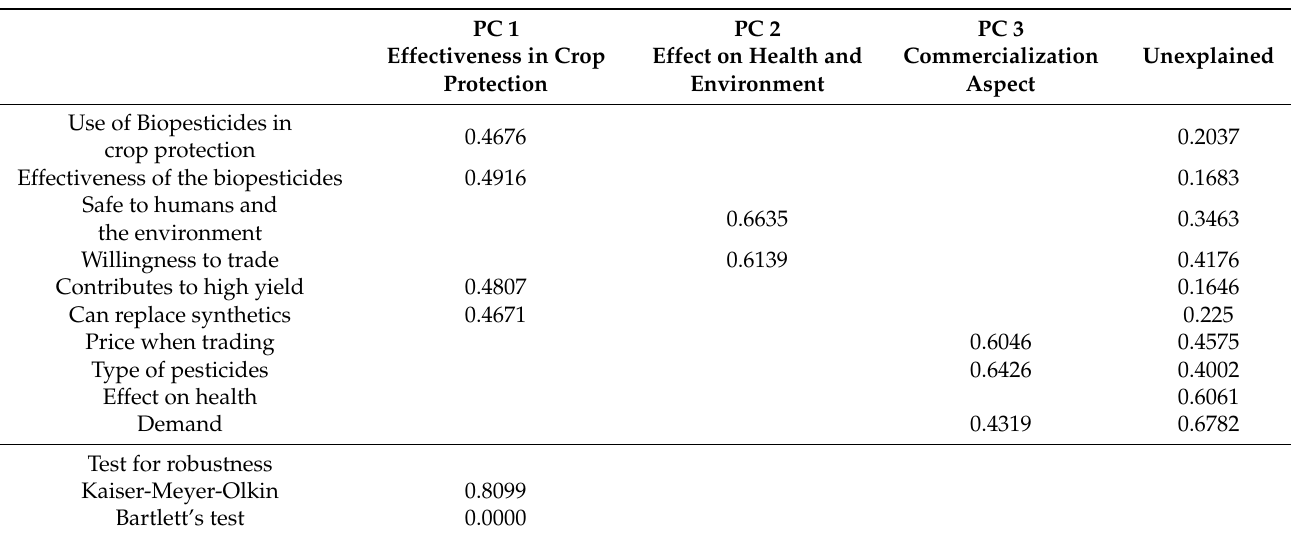
Table 3. Principal component analysis results with component